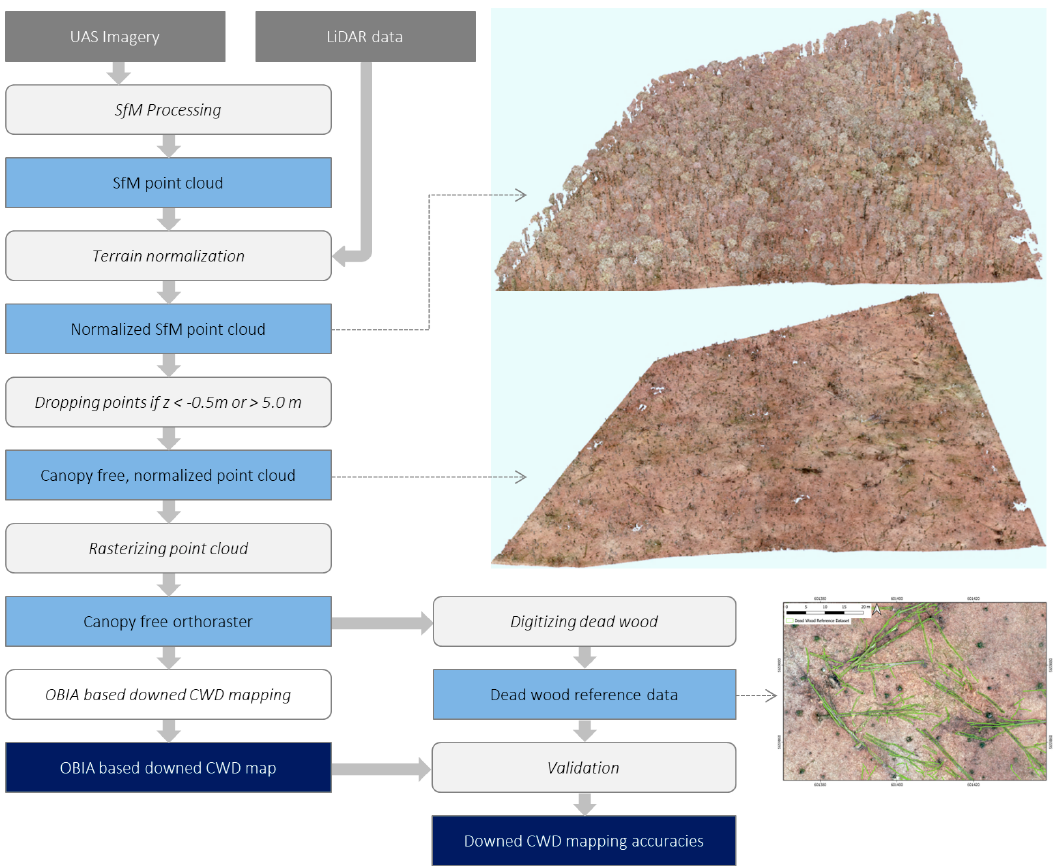
Figure 3. The overall workflow developed and applied in this study. Color coding: Grey = input data, white = processing steps, light blue = intermediate products, dark blue = final products. The reference data for validation was digitized using the canopy-free raster data.